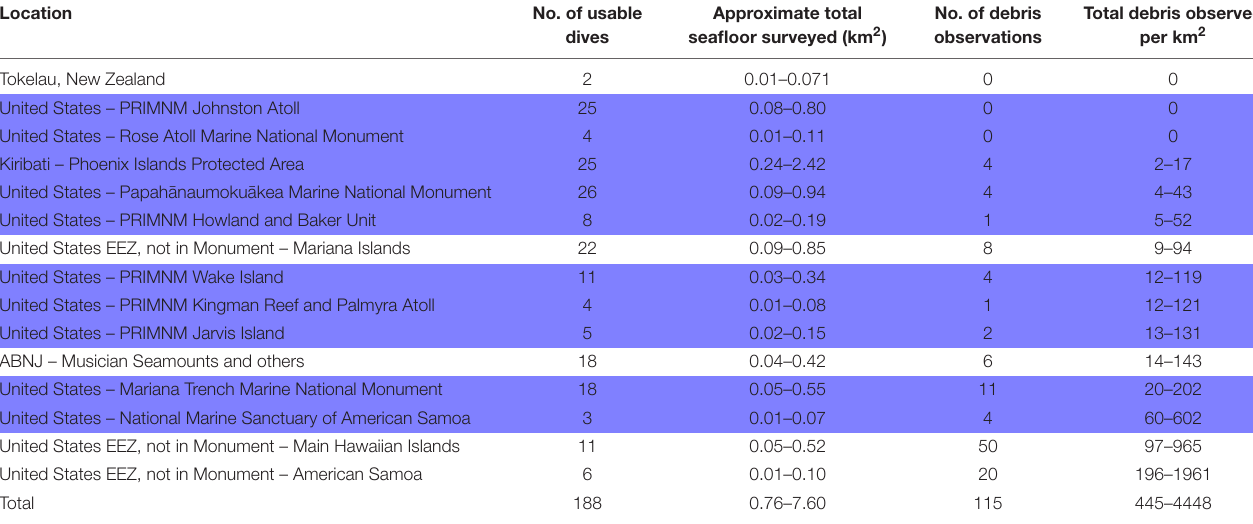
TABLE 1 | Deep-sea debris observed in the central and western